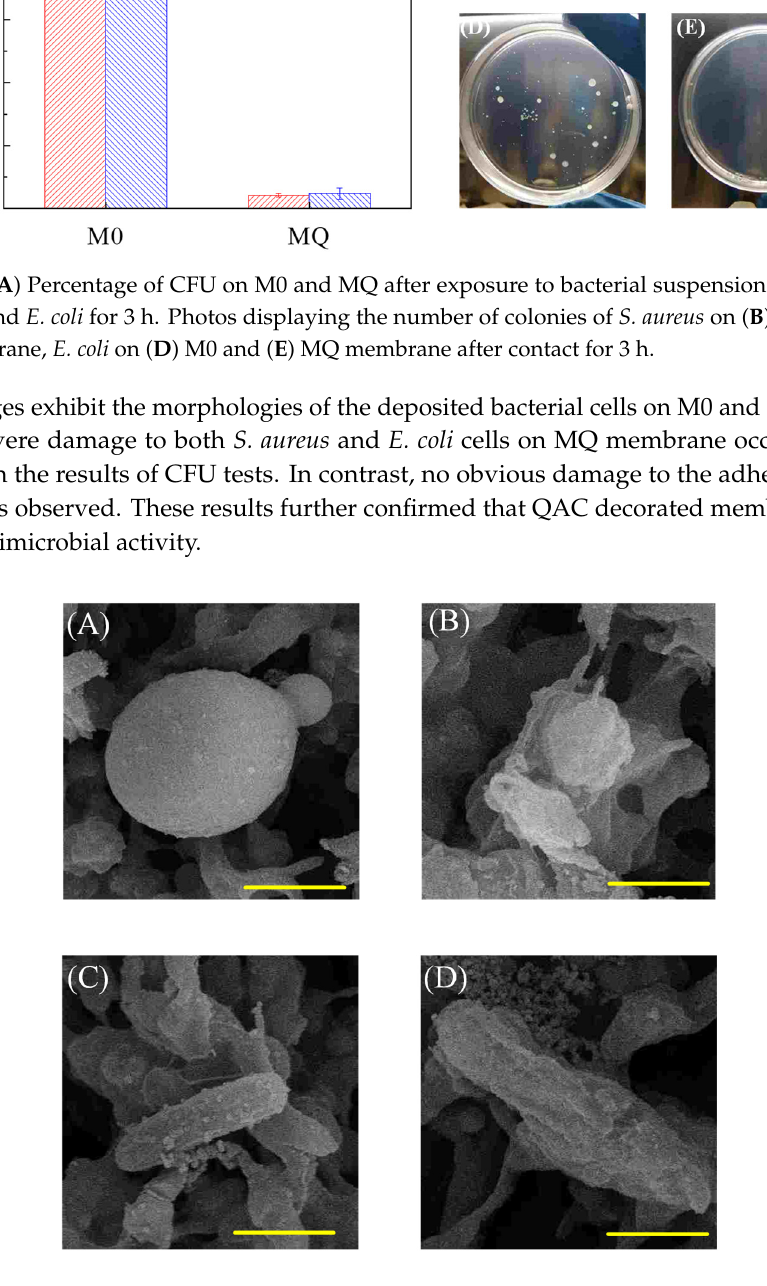
Figure 6. SEM images displaying S. aureus on ( A ) M0 and ( B ) MQ, and E. coli on ( C ) M0 and ( D ) MQ membranes. The scale of yellow bar is 1